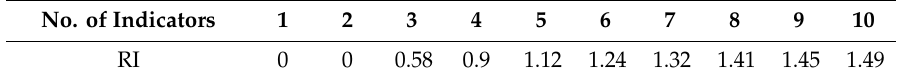
Table 6. RI (random index) based on the order of the PCM (pairwise comparison matrices) [93]. No. of